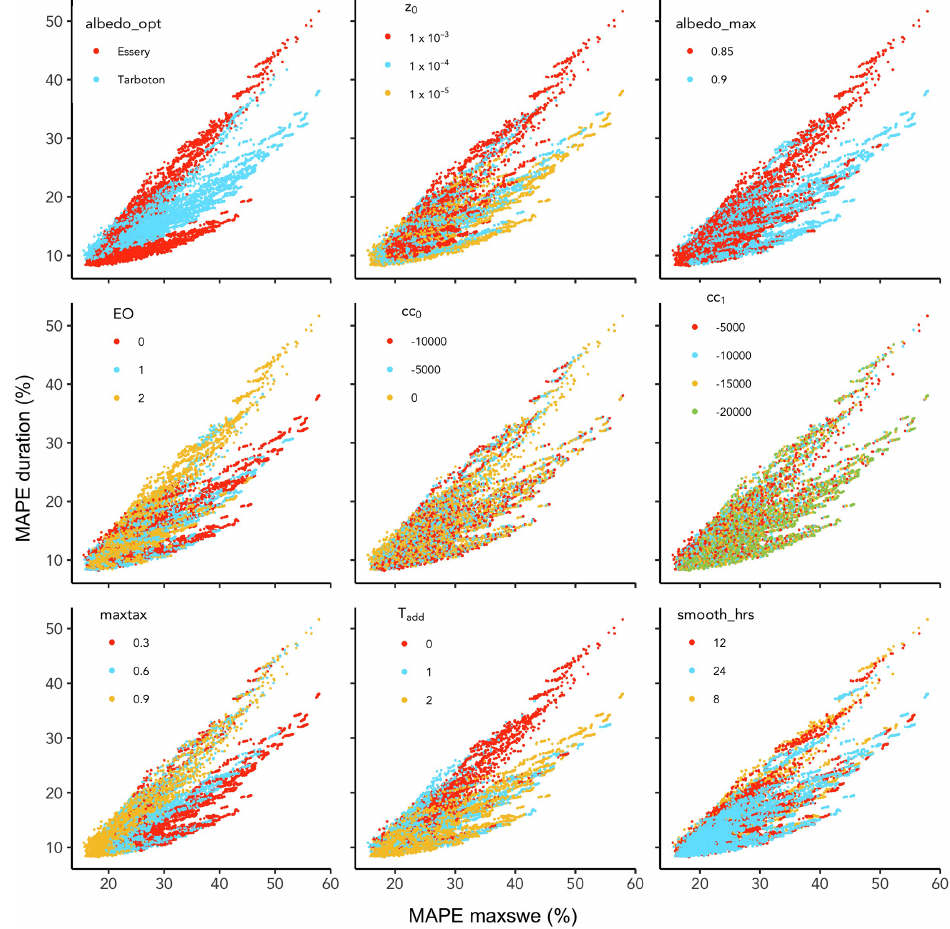
Figure B3. Parameter sensitivity of hourly model